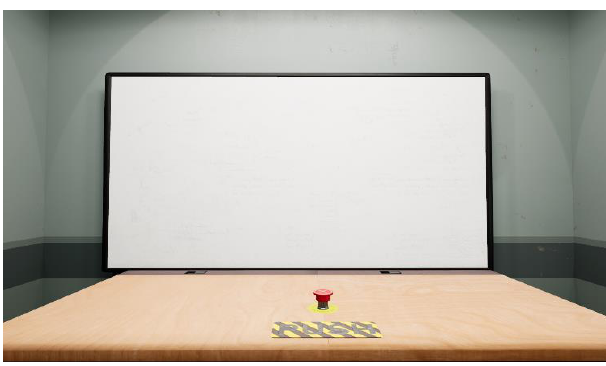
Figure 4. Example of the first screen of the iVR tutorial. 6.